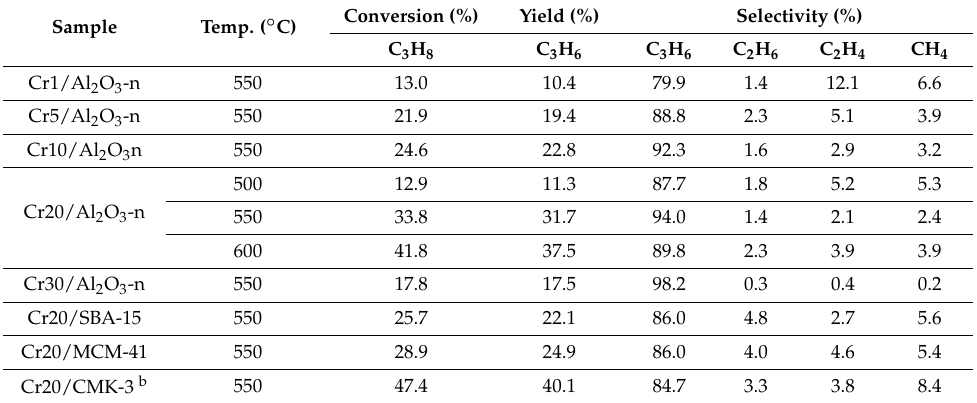
Table 3. Initial catalytic performances in dehydrogenation of propane to propene a